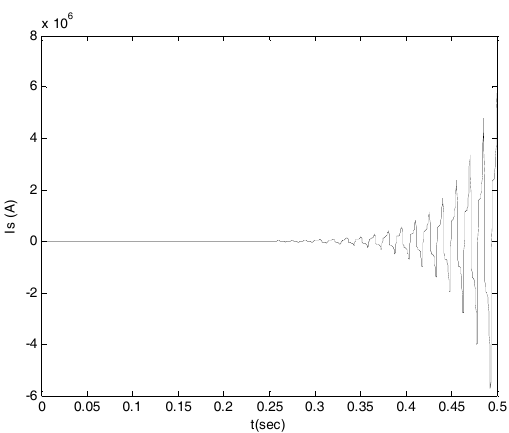
Figure 13. A computer simulation of IG with L s = 0.22 H.